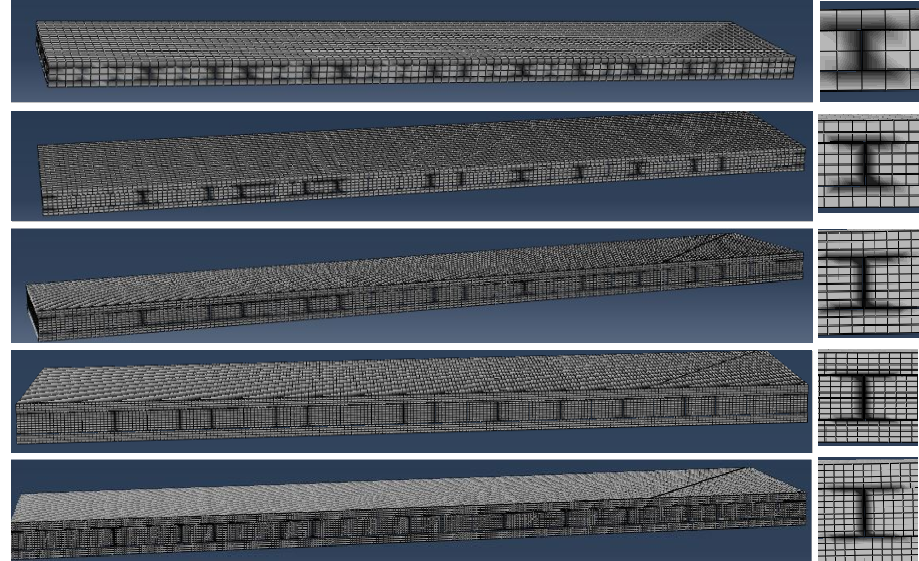
Figure 8. Final cracking at the model material geometry for five different meshes for quasi-static loading. At the right corner, a magnified local domain encapsulating crack is also given for each of the five different